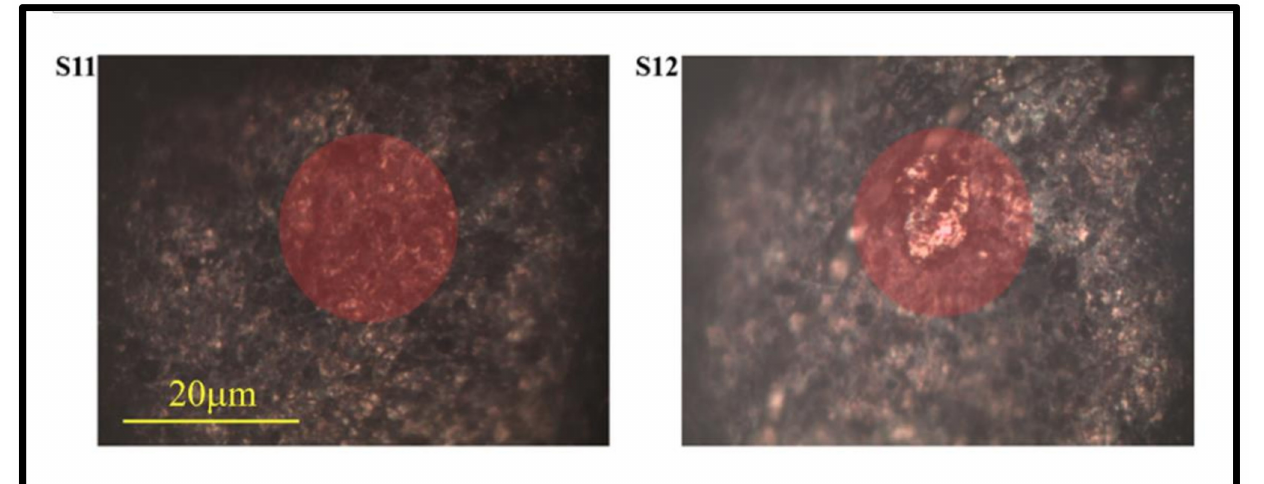
Figure 4. Collection of optical images from the investigated sectors S11 and S12 of the specimen N. 01.1622_fragment performed with the 50 × objective. The transparent red circles highlight the areas